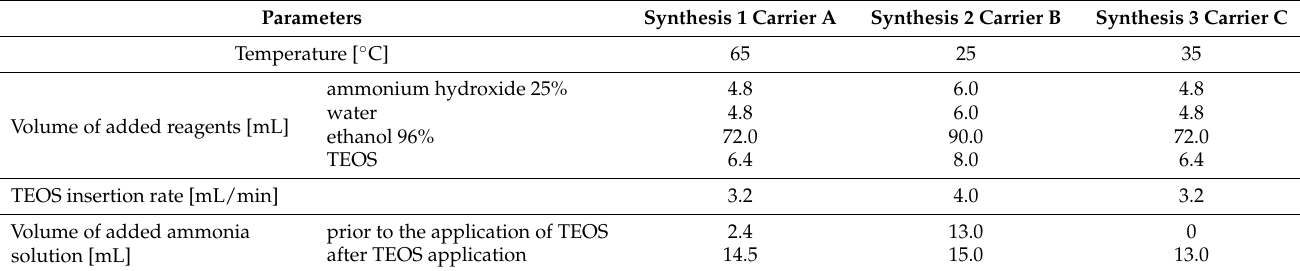
Table 1. Parameters of the synthesis of silica nanoparticles.